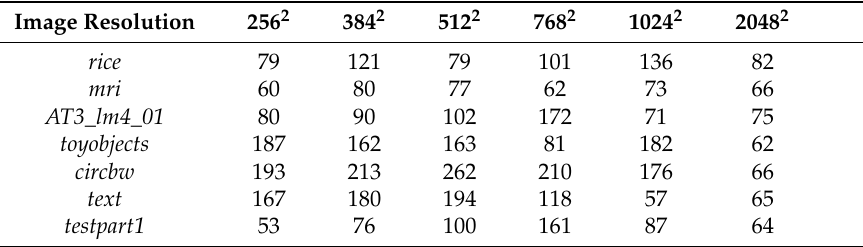
Table 5. The speedup ratio of seven